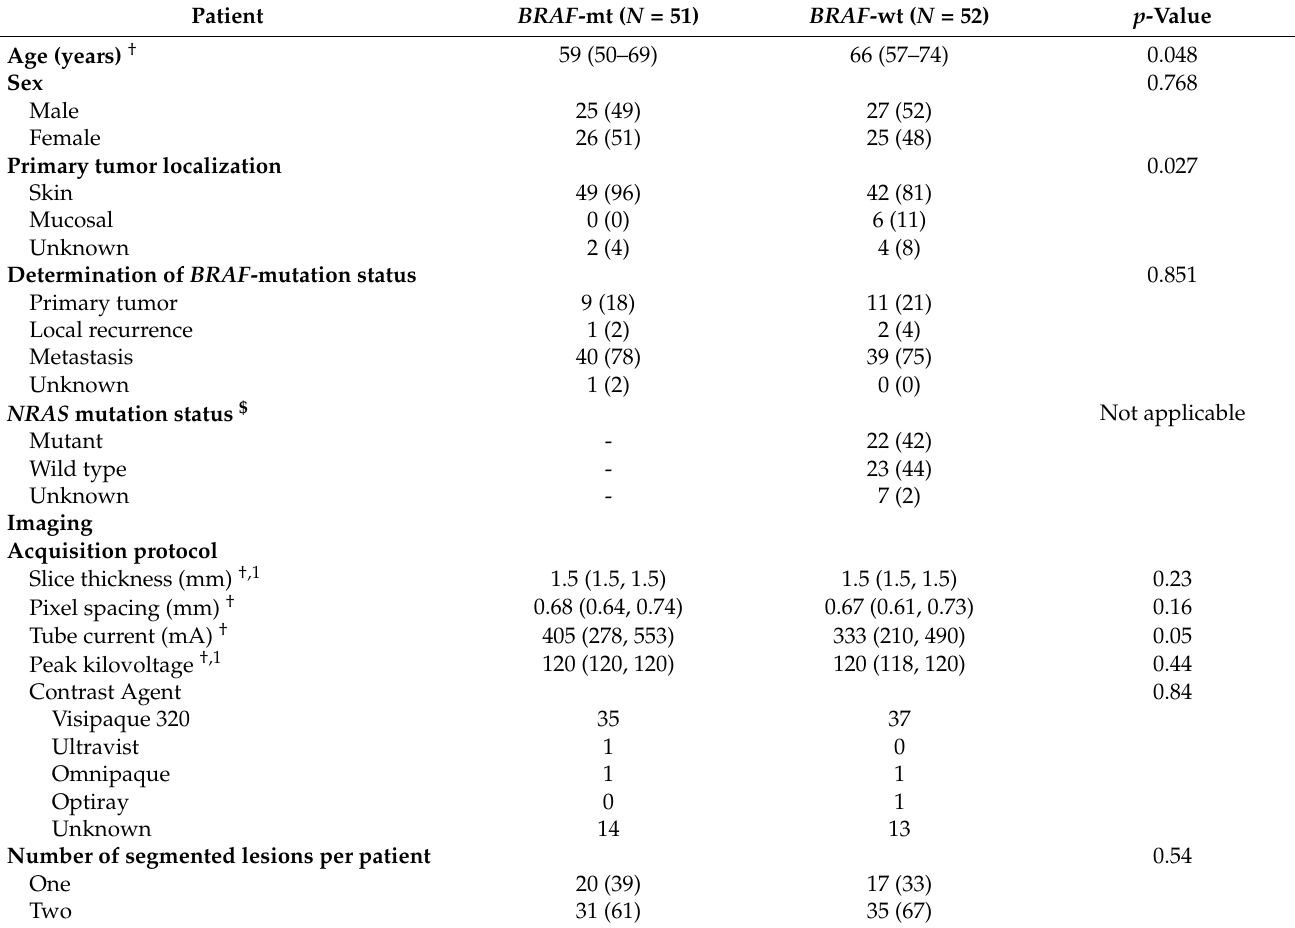
Table 1. Patient and imaging characteristics. Values in parentheses are percentages unless indicated